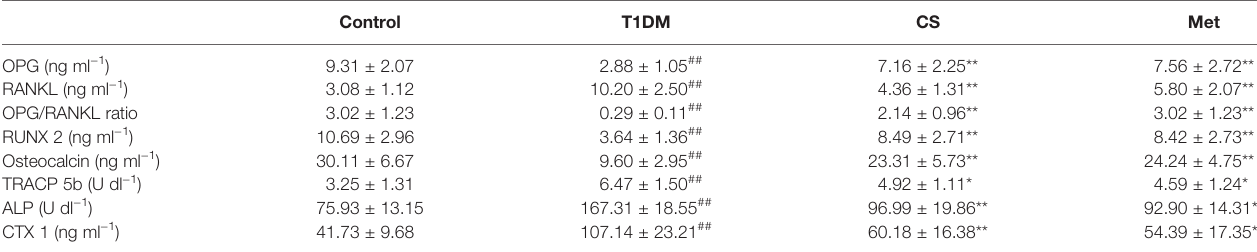
TABLE 1 | Bone turnover markers in different groups at the end of the 10th week.